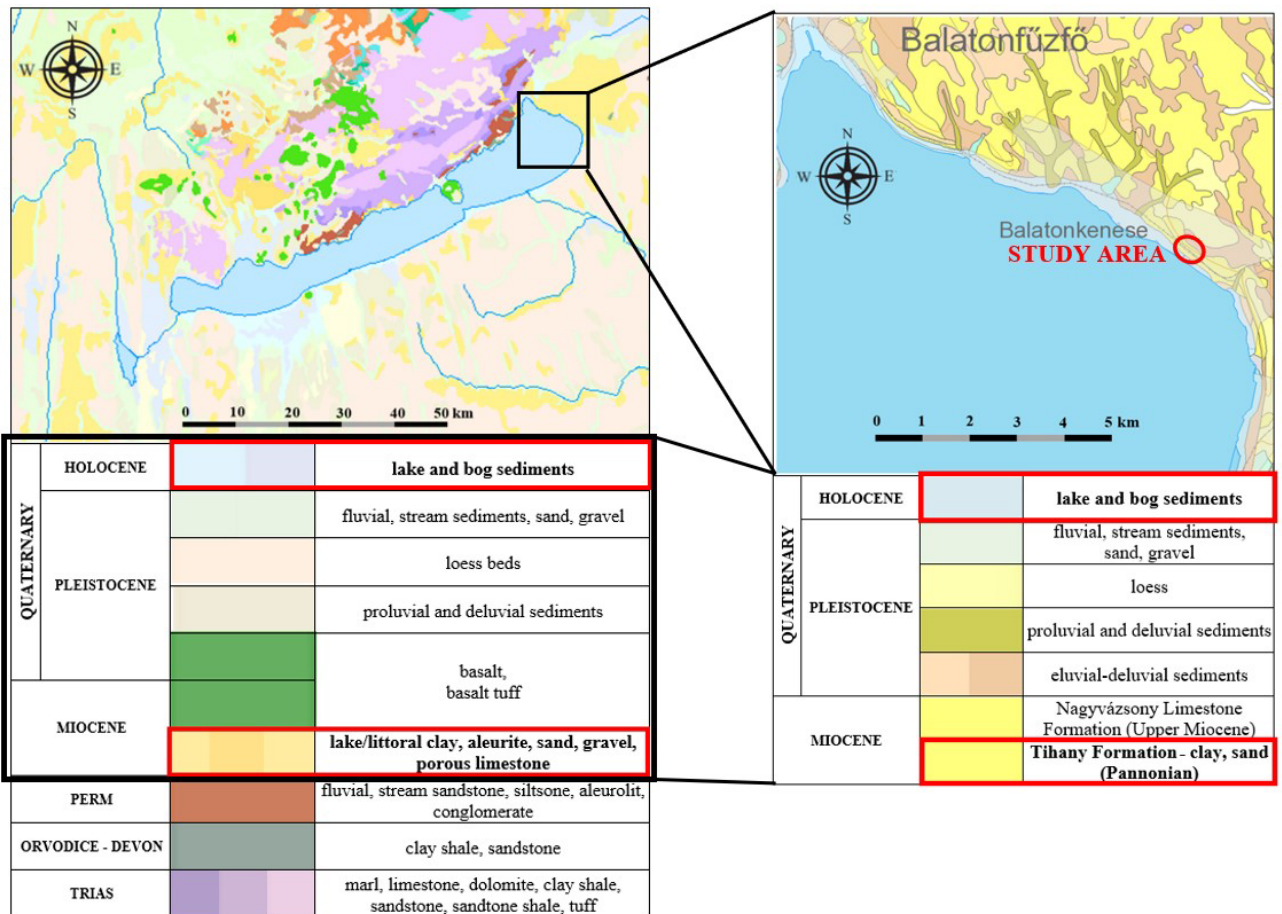
Figure 2. The geological conditions of the study area (explanations from the online maps [42,43]).